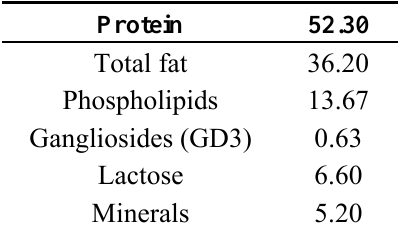
Table 1. Composition of beta serum concentrate (BSC) (g/100